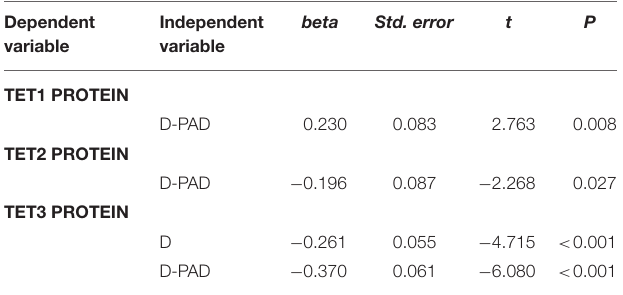
TABLE 4 | Multiple linear regression analysis to compare the TET1, TET2, and TET3 protein levels in ND group with that in D and D-PAD groups. Dependent variable